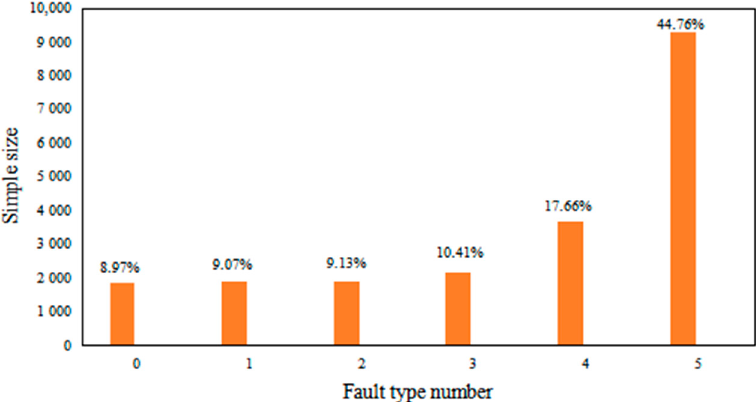
Figure 5. Distribution of fault samples after mixed sampling. Table 1. Change in sample proportion after mixed sampling method.